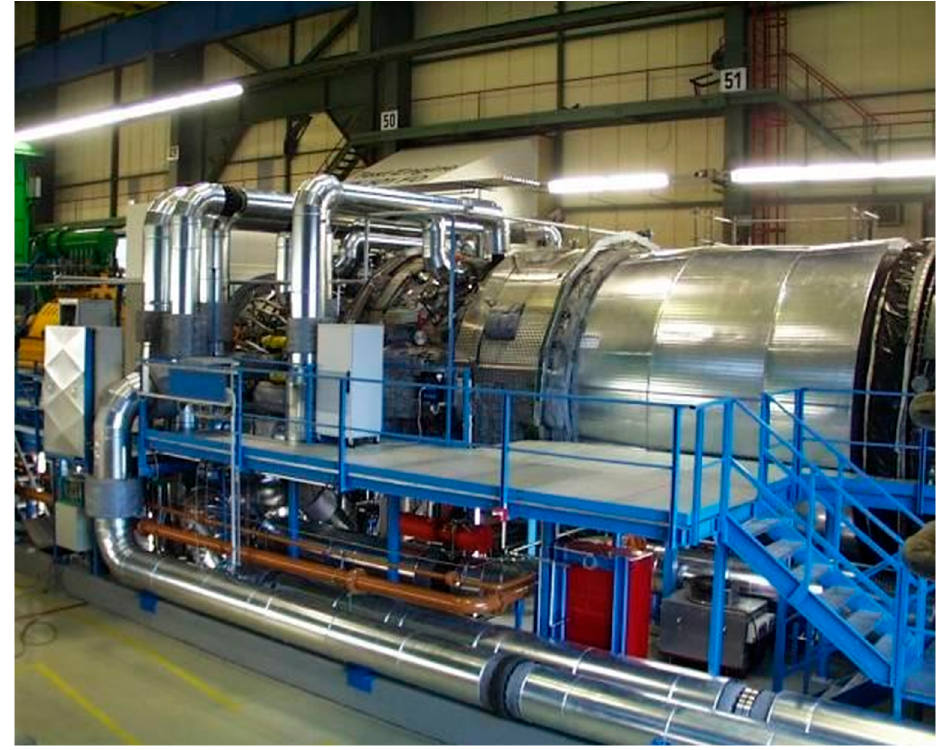
Figure 5. A view of the SIEMENS brand gas turbine, model SGT6-5000F [51]. Table 2. GTL input and output variables.